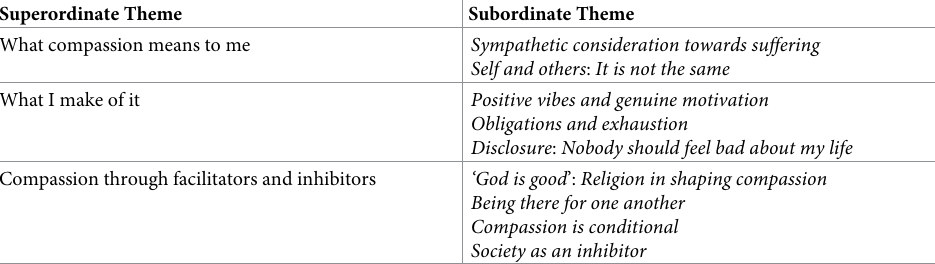
Table 2. Superordinate themes and subordinate